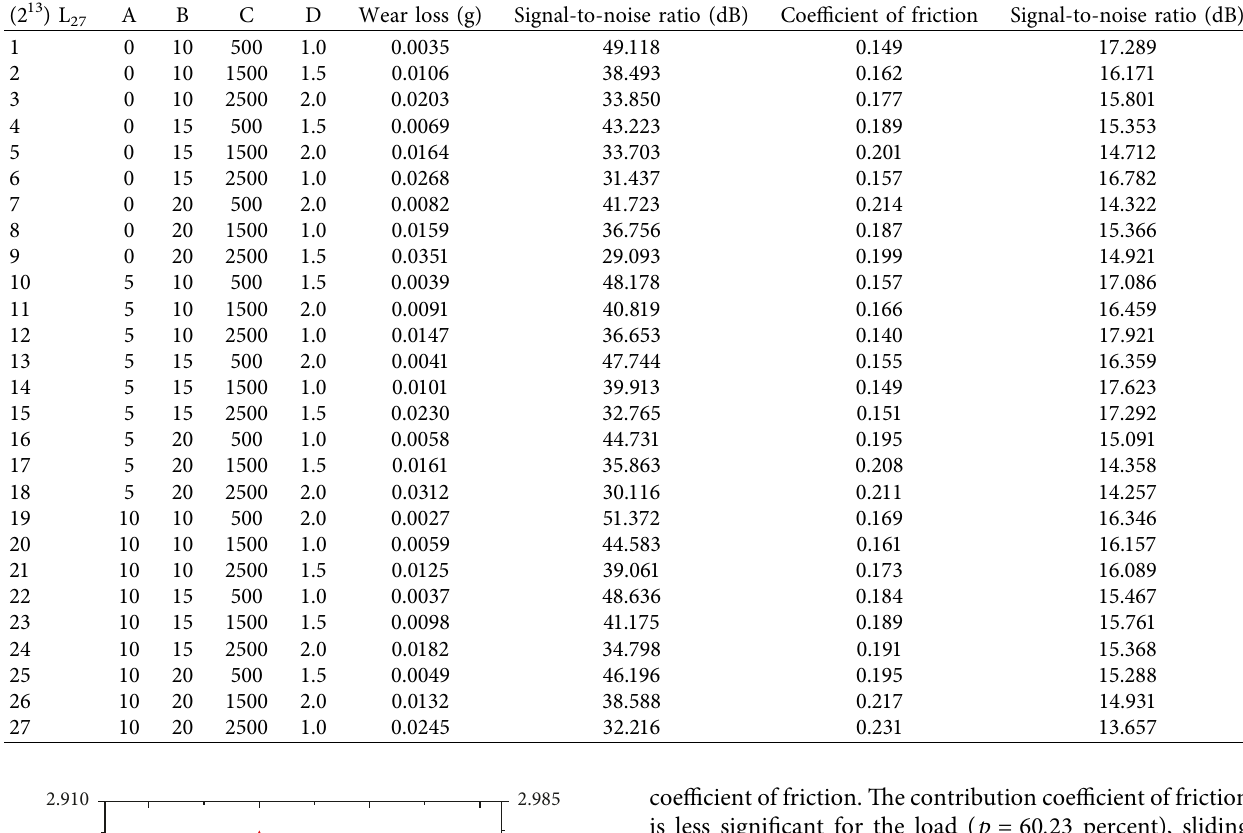
13 ) orthogonal array. 27 (3